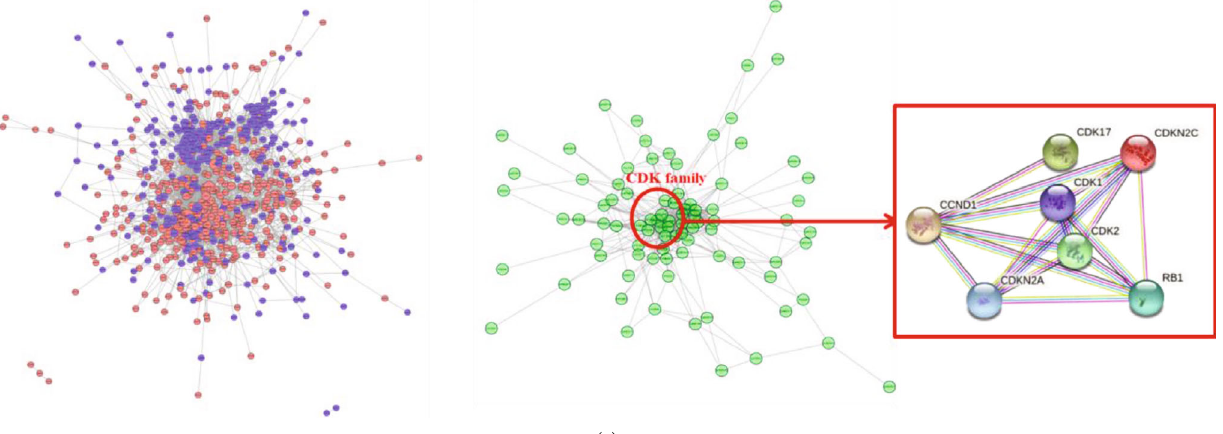
Figure 5: KEGG pathway analysis of hypoxia-induced hBMSCs. (a) KEGG pathway enrichment analysis of di ff erentially expressed proteins from cells treated with or without hypoxia. The upregulated (red) proteins were mainly involved in cytokine-cytokine receptor interactions and complement and coagulation cascades, whereas the downregulated (green) proteins were mainly involved in cancer pathways, the PI3K- Akt signaling pathway, proteoglycans in cancer, hepatocellular carcinoma, and cellular senescence. (b) KEGG pathway annotation statistics of di ff erentially expressed proteins (top 20). The signaling pathway annotations of di ff erentially expressed proteins were critically related to pathways in cancer (34 proteins), Alzheimer disease (25 proteins), amyotrophic lateral sclerosis (24 proteins), the PI3K-Akt signaling pathway (23 proteins), and Huntington disease (23 proteins). (c) The role of the CDK cluster and CCND1 in the PI3K signaling pathway. (d) The role of the CDK cluster in the p53 signaling pathway. (e) PPI network of di ff erentially expressed proteins in the 12-hour hypoxia- induced group. PPI analyses indicated that CDK1, CDK2, and CCND1 were important nodes. STRING network bonds. Blue: from curated databases; rose pink: experimentally determined; green: gene neighborhood; red: gene fusions; navy blue: gene co-occurrence; yellow: text mining; black: coexpression; purple: protein